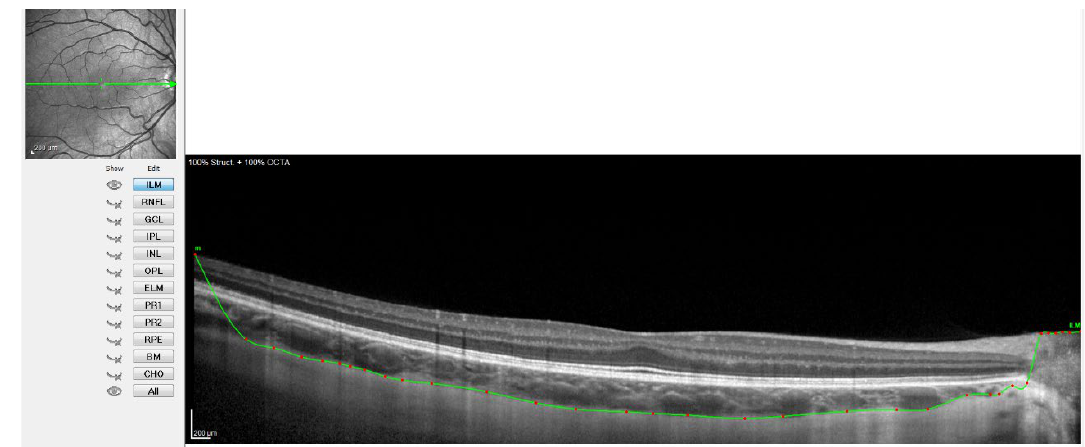
Figure 2. OCT image with the line of the internal limiting membrane marked in green, point by point.